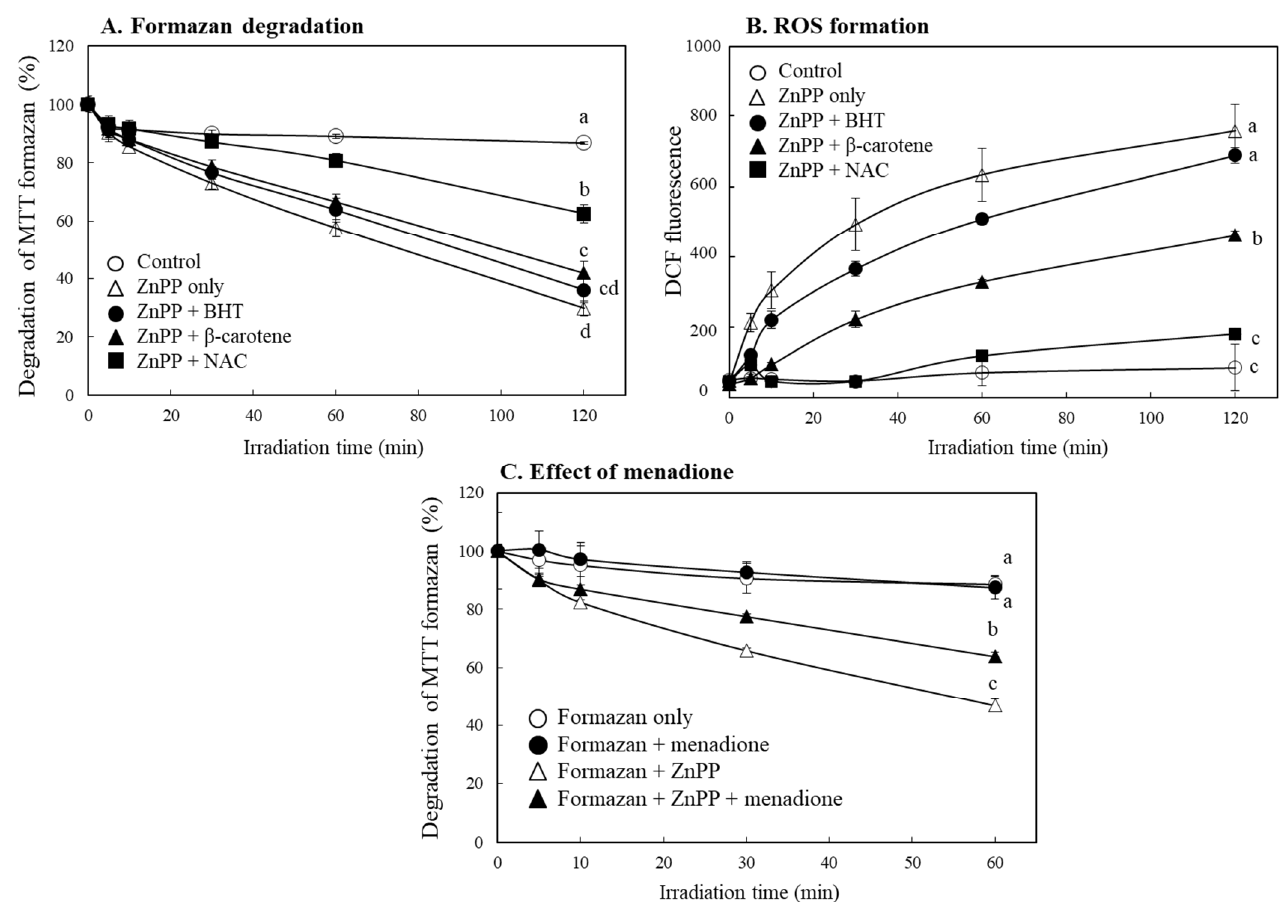
Figure 8. Effects of different antioxidants and menadione on MTT formazan degradation by por- phyrins and DCF fluorescence. Effects of different antioxidants (each 25 µ M) on the degradation of MTT formazan ( A ) and enhancement of DCF fluorescence ( B ) by ZnPP (5 µ M) under light exposure were analyzed for 2 h. MTT formazan dissolved in DMSO was mixed with ZnPP (5 µ M) and mena- dione (40 µ M), an electron coupling agent, and color response of MTT formazan was also analyzed under light ( C ). Each value represents the mean ± SD ( n = 3). Different letters indicate a significant